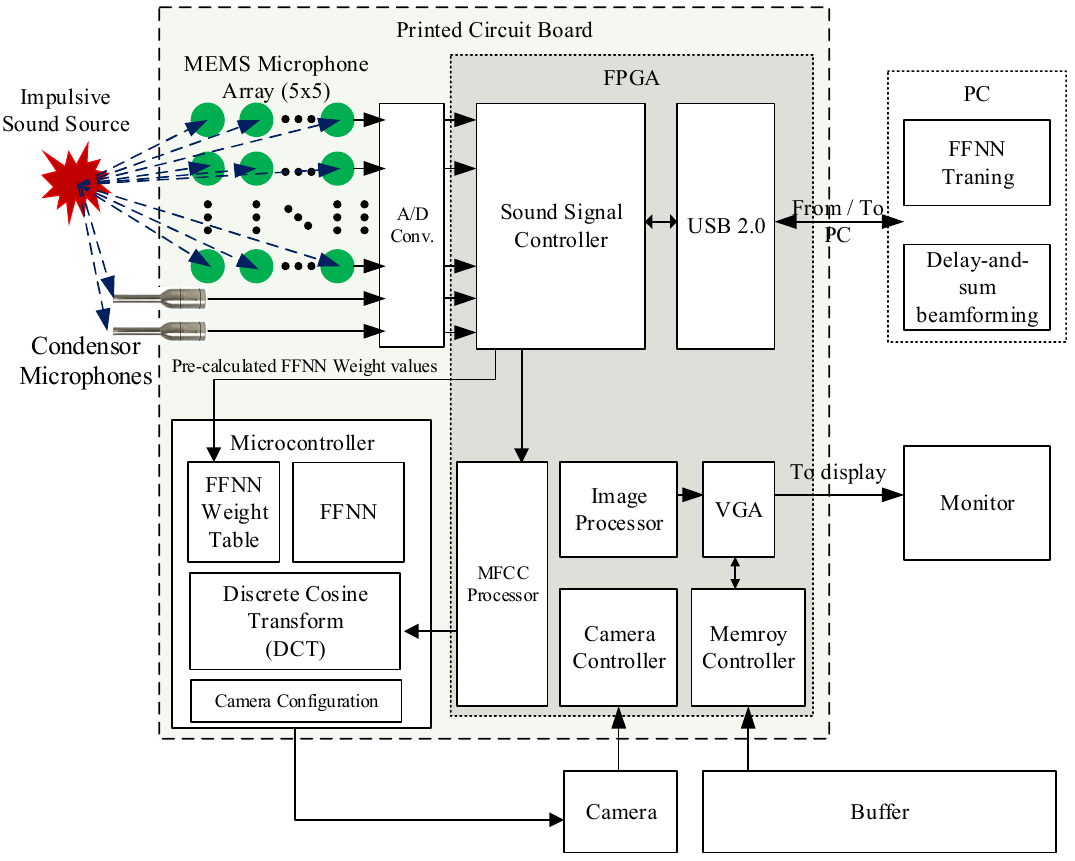
Figure 2. The hardware design for impulsive sound detection using a MFCC-FFNN scheme.